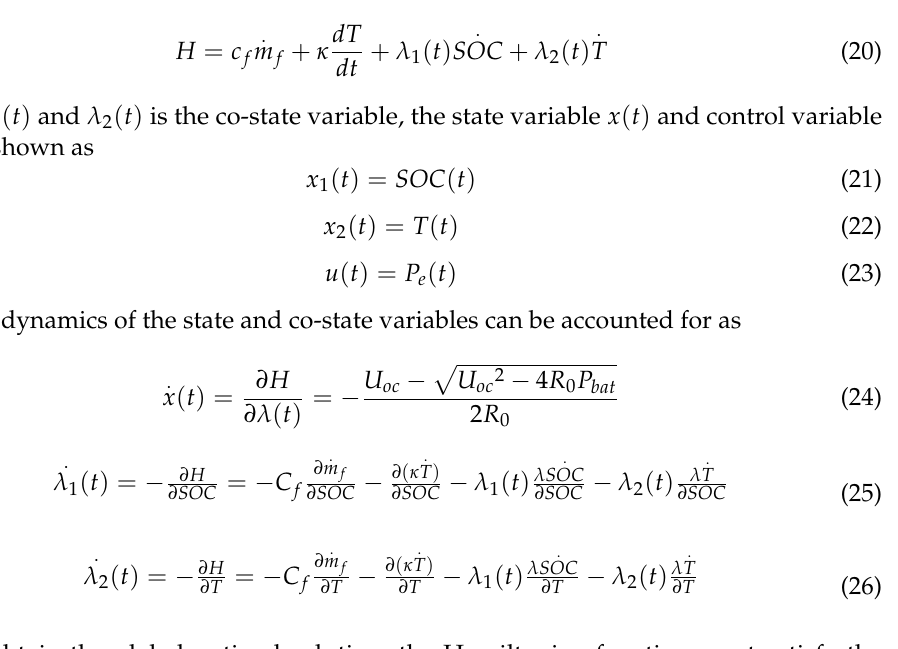
κ on battery temperature. Figure 8. Influence of weighting factor